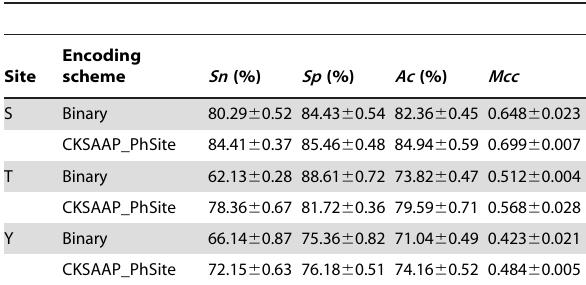
Table 4. Comparison of the two encoding schemes on the training dataset containing no ‘O’ residues.